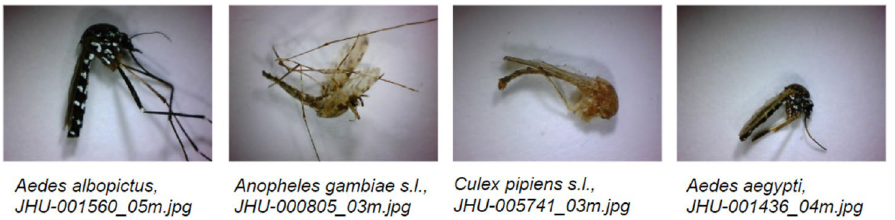
Figure 1. Example image database samples of wild-caught mosquitoes. Field specimens were often considerably damaged, missing appendages, scales, and hairs, like specimens captured during standard mosquito surveillance practice.